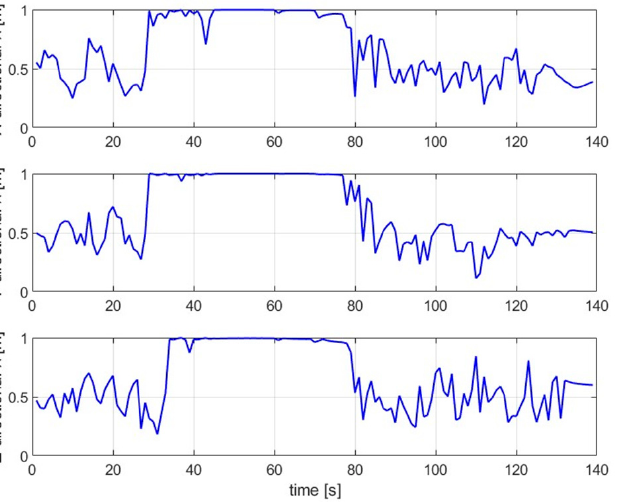
Figure 8. Divergence indices in the fission–fusion process of UAV swarm under the anti-catch situation.